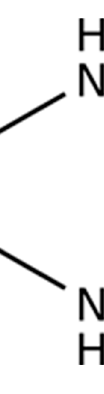
Figure 1. Molecular structure of the piperazine.